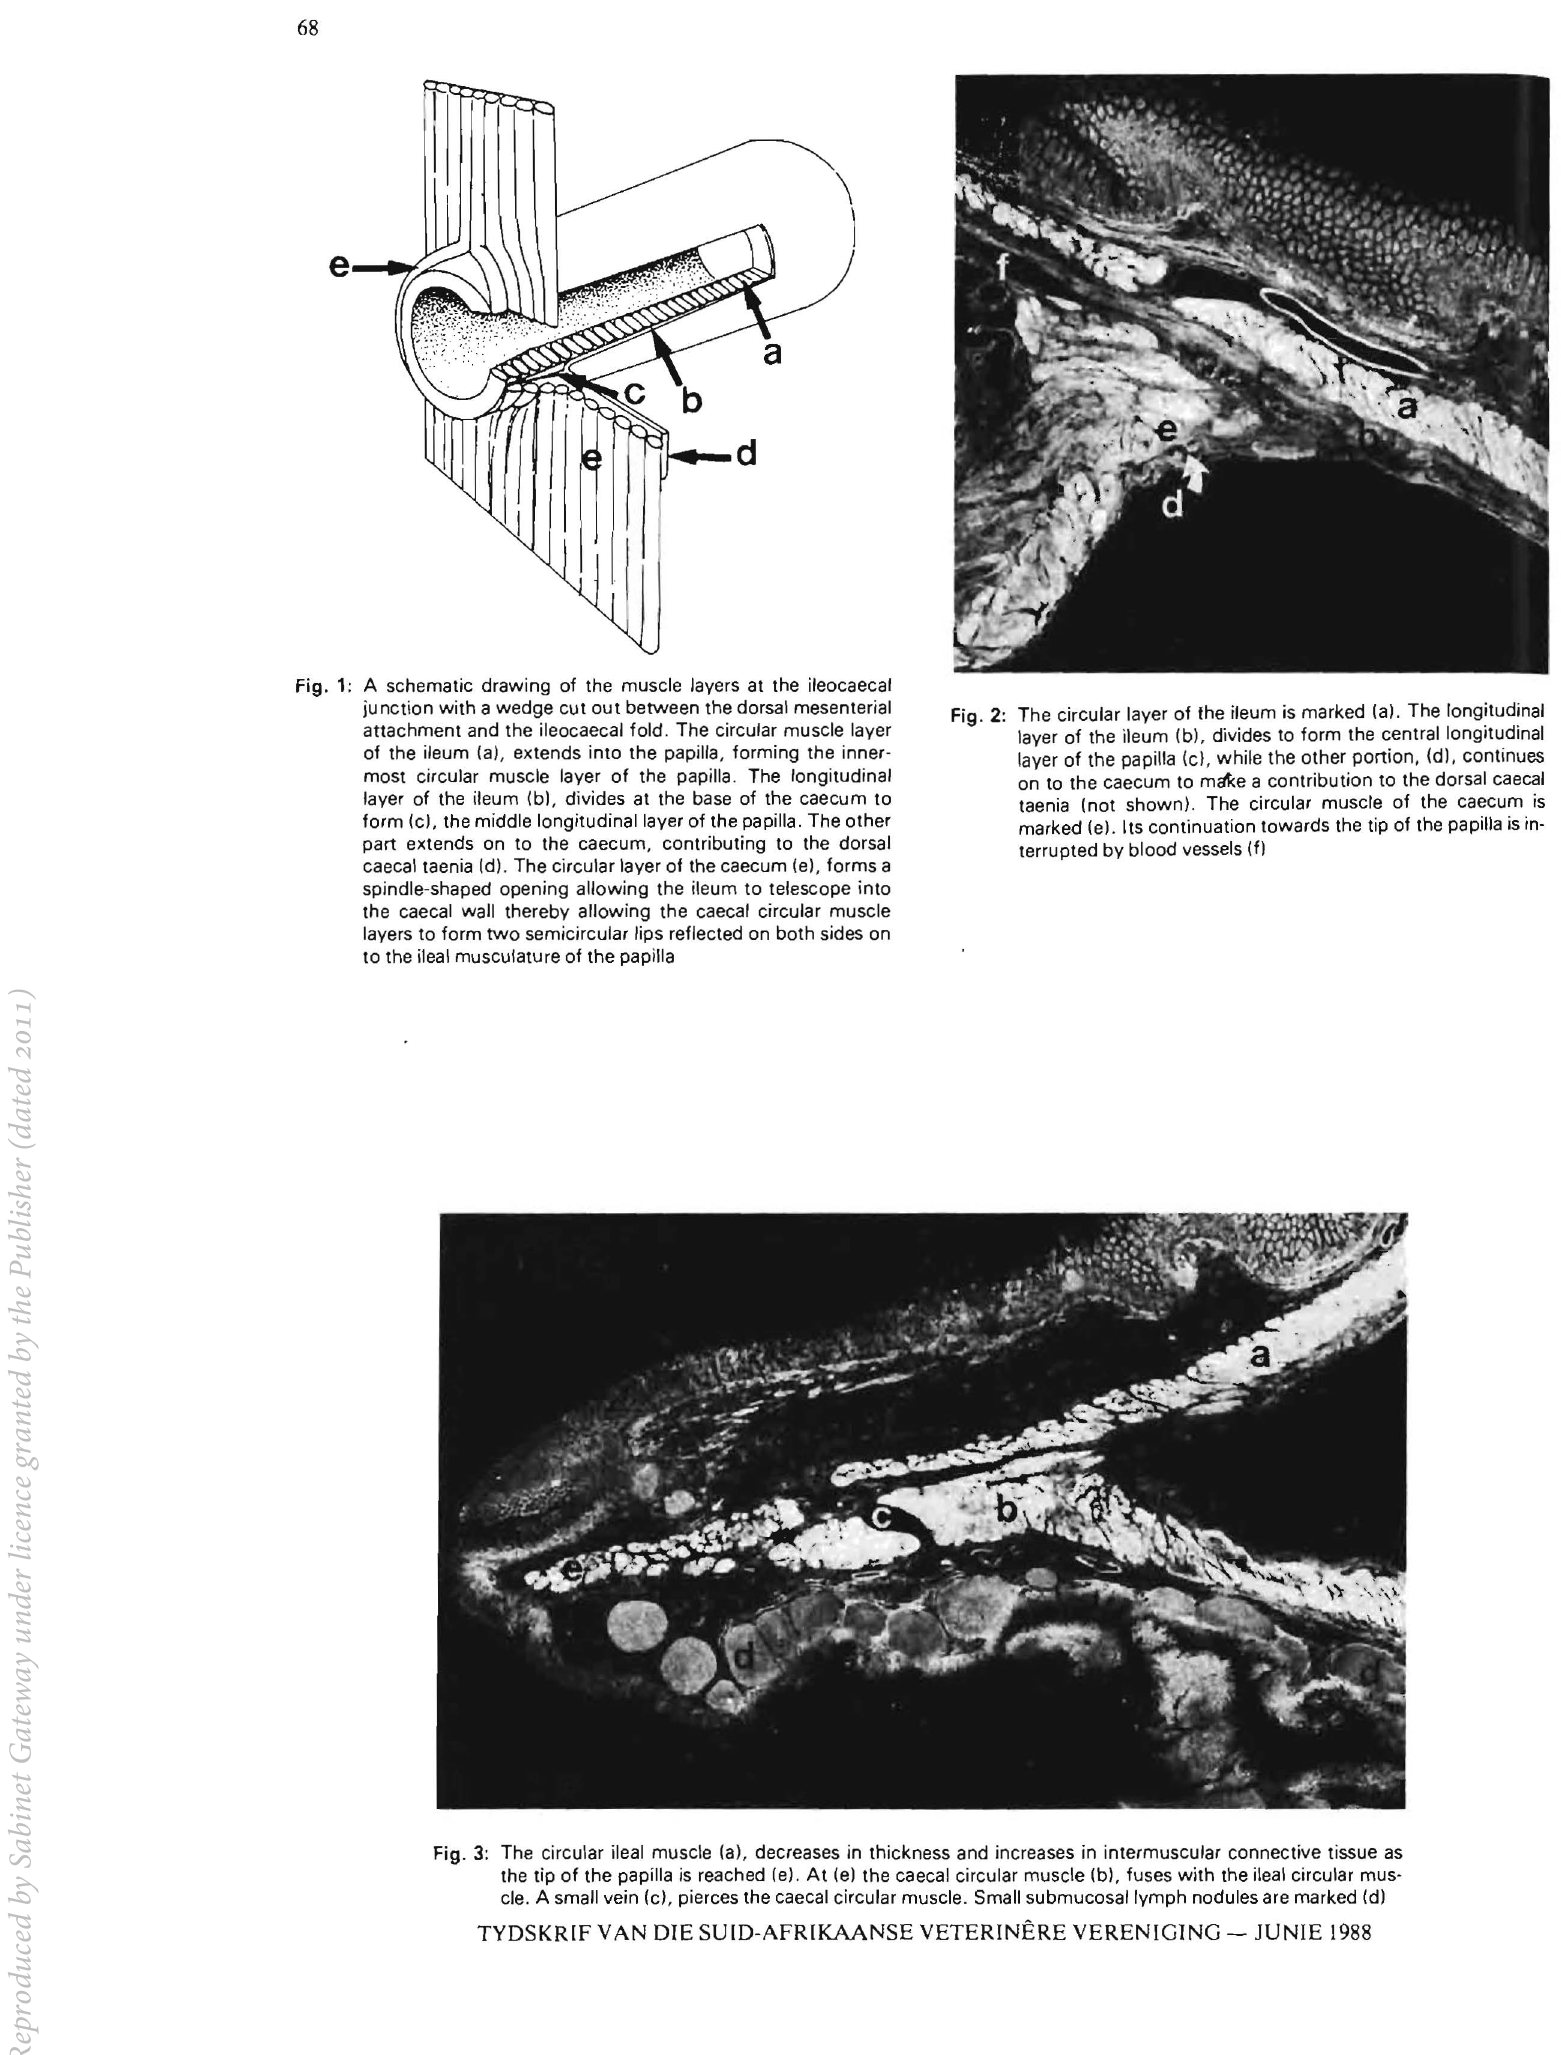
Fig. 3: The circular ileal muscle la), decreases in thickness and increases in intermuscular connective tissue as the tip of the papilla is reached leI. At Ie) the caecal circular muscle Ib), fuses with the ileal circular mus cle. A small vein Ic), pierces the caecal circular muscle. Small submucosal lymph nodules are marked Id) TYDSKRIF VAN DIE SUID-AFRIKAANSE VETERINERE VERENIGING - JUNIE